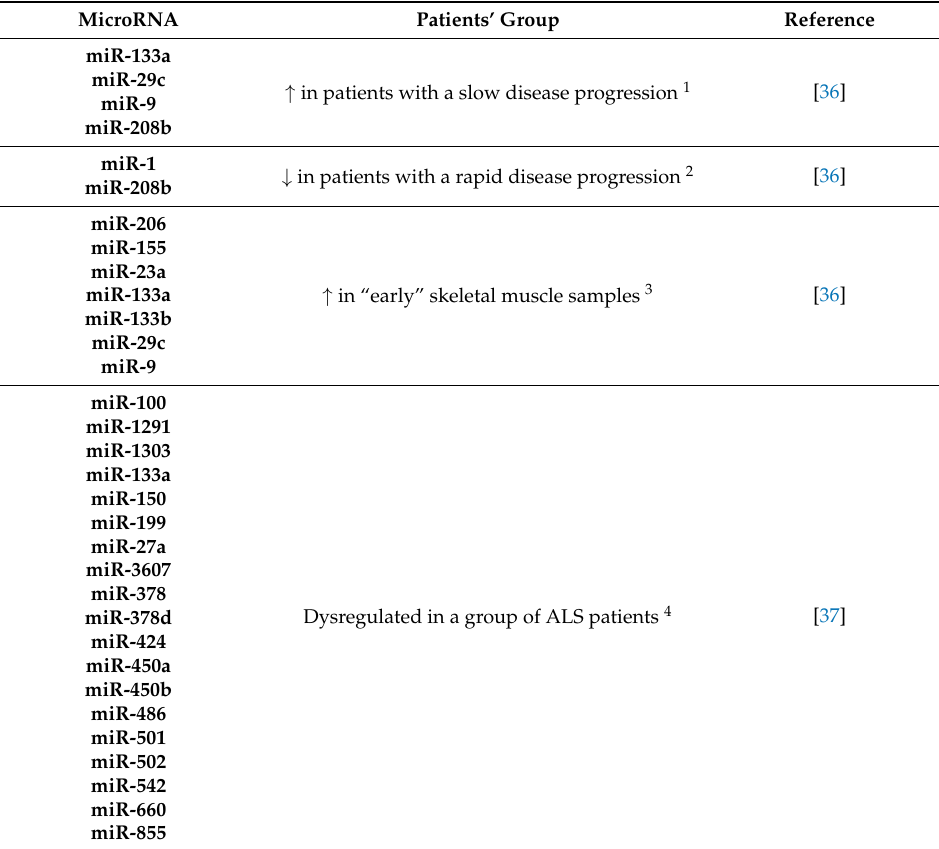
Table 2. Dysregulated microRNAs in specific groups of ALS patients with respect to